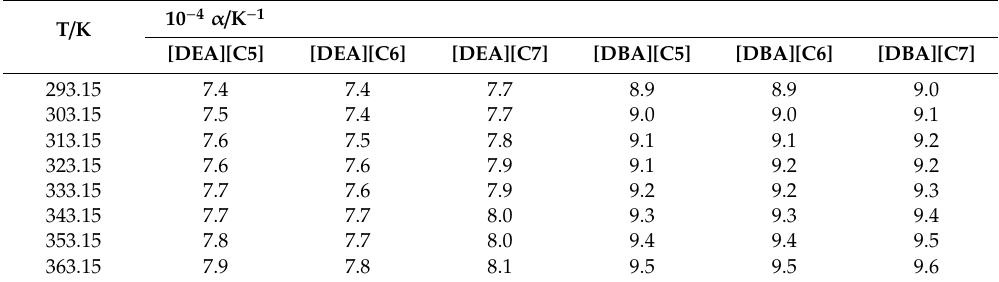
Table 5. Thermal expansion coe ffi cients ( α p ) of the PILs calculated using Equation (4). T /